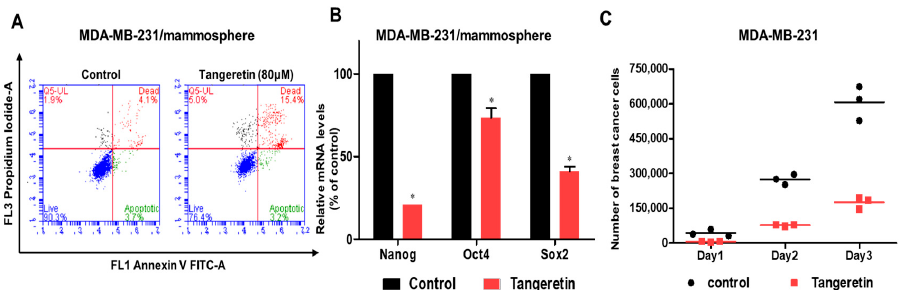
Figure 4. The e ff ects of tangeretin on apoptosis and mammosphere growth. ( A ) Tangeretin modestly induced apoptosis in mammospheres treated with tangeretin. We induced mammosphere formation and treated mammospheres with tangeretin. After treatment, apoptotic cells were examined using Annexin V/PI staining. ( B ) Transcription levels of CSC markers, including the Nanog, Sox2 and Oct4 genes, determined in tangeretin- and DMSO-treated mammospheres using CSC marker-specific primers and real-time PCR. β -actin acts as an internal control. The data shown represents the mean ± SD of three independent experiments. * p < 0.05 vs. DMSO-treated control. ( C ) Tangeretin inhibited mammosphere growth. Mammospheres with or without tangeretin were dissociated into single cells, and the single cells were plated in 6 cm dishes in equal numbers. The cells were examined one, two and three days later.